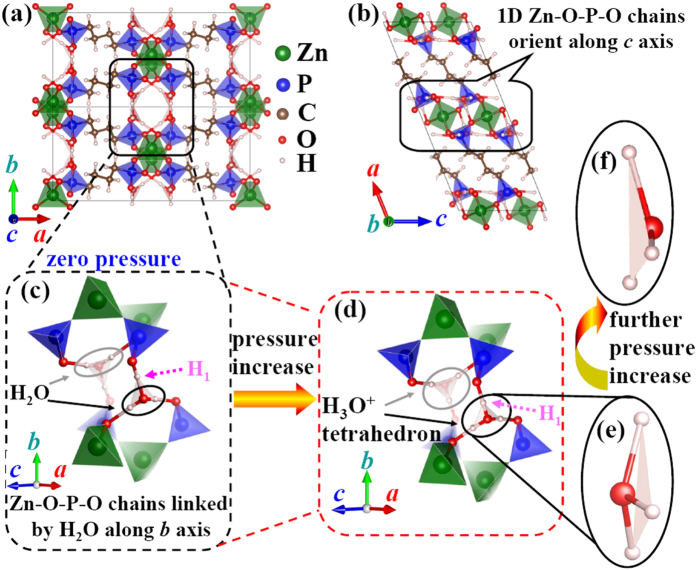
Structural details of ZAG-4.(a) ZAG-4 viewed along [0 0 1] direction. (b) ZAG-4 viewed along [0 1 0] direction. (c) Partial enlargement of (a), viewed approximately along [1 0 1] direction. At zero pressure, H1 is close to PCO3 and far away from H2O. (d) H1 moves away from PCO3 with the increase of pressure, and then H3O+ tetrahedron is formed. (e) Side view enlargement of H3O+ tetrahedron. (f) With further pressure increase, apex oxygen penetrates H3O+ tetrahedron base and moves to the other side of hydrogen plane.